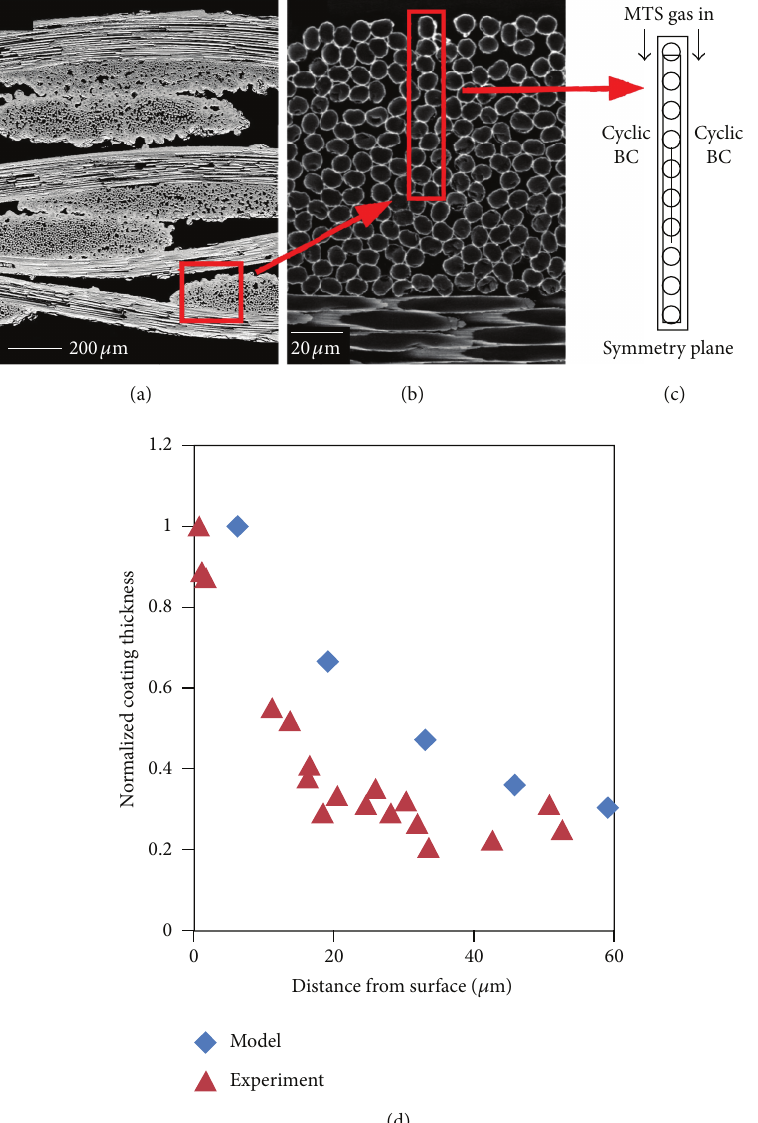
Figure 5: (a) Cross-section of stacked fabric layers, (b) cross-section of fiber bundle, (c) model geometry showing MTS introduction and boundary conditions, and (d) comparison between simulated and experimentally observed SiC deposition gradients into the fiber